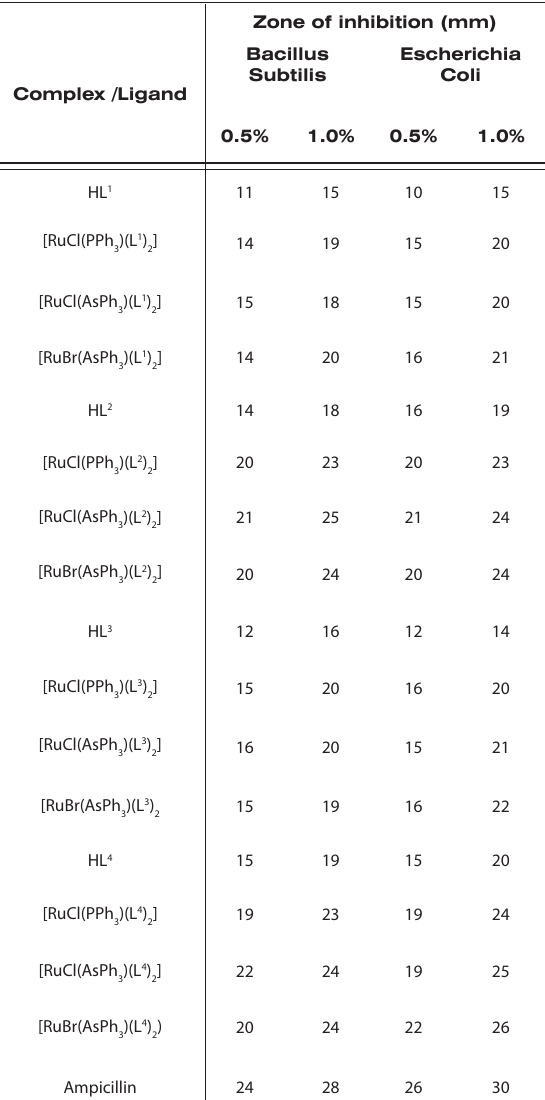
Figure 3. The cyclic voltammogram of [RuCl(AsPh